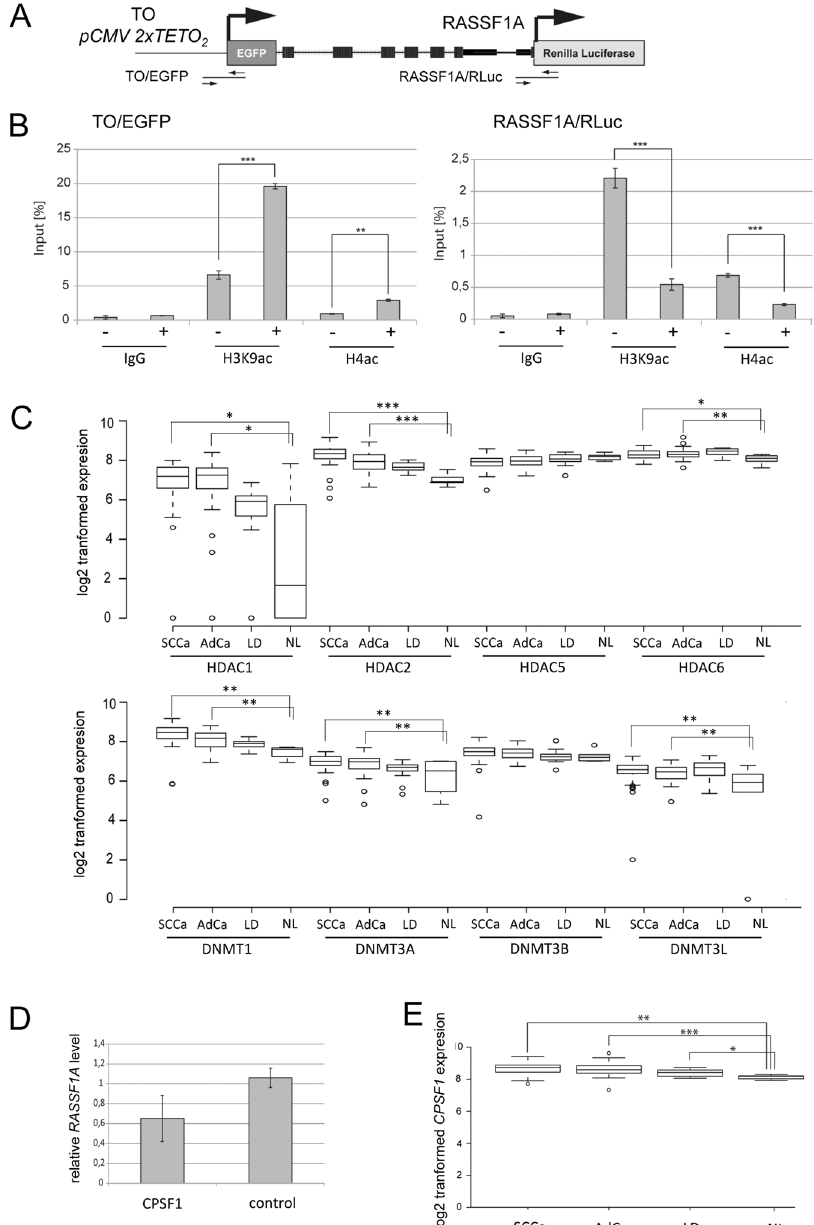
Figure 6. Epigenetic regulation of tandem genes in lung cancer. ( A ) Outline of the tandem oriented reporter gene construct analyzed by chromatin immuno-precipitation (ChIP). The analyzed TO/EGFP and RASSF1A/ RLuc promoter regions are depicted. For details see Fig. 5. ( B ) TREx293 cells stably transfected with TO- EGFP-2.3-RLuc (clone B7) were induced with 4 mM Dox ( + ) or uninduced ( − ) for four days (d) and histone modifications were analyzed by ChIP. Chromatin was precipitated with anti histone H3K9ac, histone H4ac and IgG antibodies (negative control) antibodies. DNA was isolated and analyzed by qPCR. Levels are plotted relative to 1% of input sample. ( C ) Expression of HDAC1 , HDAC2 , HDAC5 , HDAC6 , DNMT1 , DNMT3A , DNMT3B and DNMT3L was analyzed by microarray in 49 primary squamous cell lung cancer (SCCa), 41 primary lung adenocarcinoma (AdCa), 15 non malignant lung disease samples (LD) and 6 normal lung tissues (NL) 2 . Data are depicted as log2 transformed expression. ( D ) CPSF1 induced repression of RASSF1A. CPSF1 was cloned in pCMV-Tag1 and overexpressed in A427 cells. Endogenous RASSF1A level were analyzed by qRT- PCR and plotted relative to the empty control vector ( = 1). ( E ) Expression levels of CPSF1 in SCCa, AdCa, LD and NL. * p < 0.05, ** p < 0.01 and *** p <